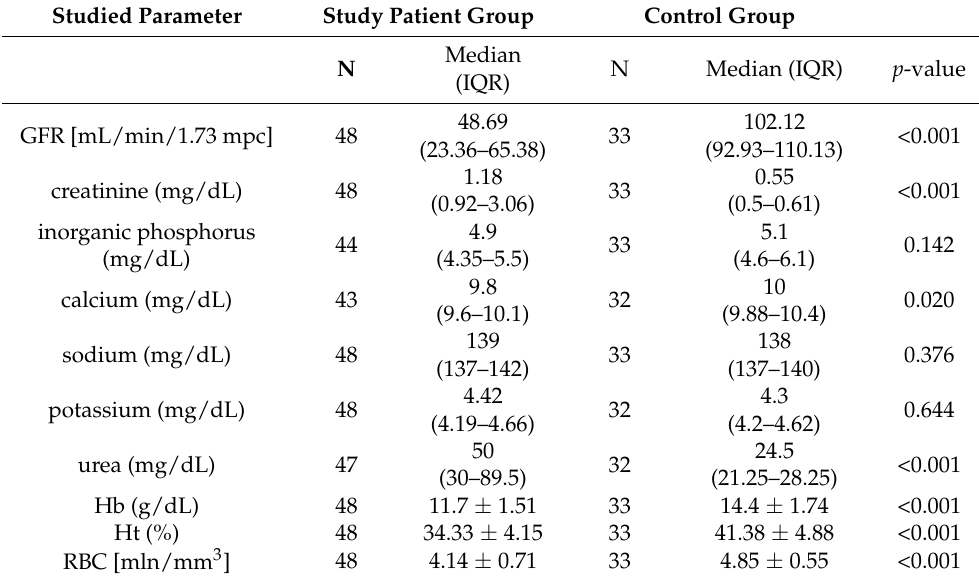
Table 1. The biochemical characteristics of the blood of the studied patient population and control group.